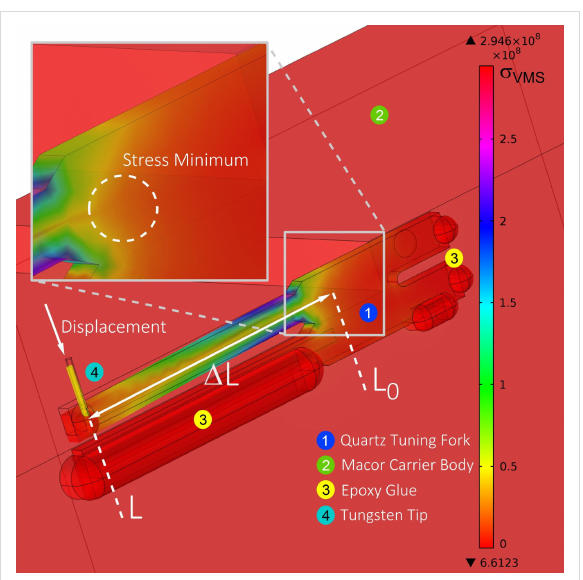
Figure 5: FEM simulation of von Mises stress. Analysis of the stress caused by the bending of the free prong. In contrast to the model for the beam formula, in which a cantilever is fixed at one end, the stress in the quartz tuning fork reaches beyond the end of the prong far into the basis of the tuning fork. The origin of the minimal Van Mises stress is indicated by the dashed circle (see